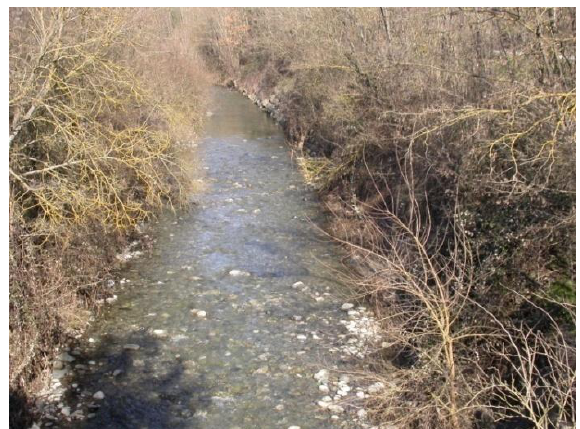
Figure 10. Example of area for which DTMs overestimate land elevation